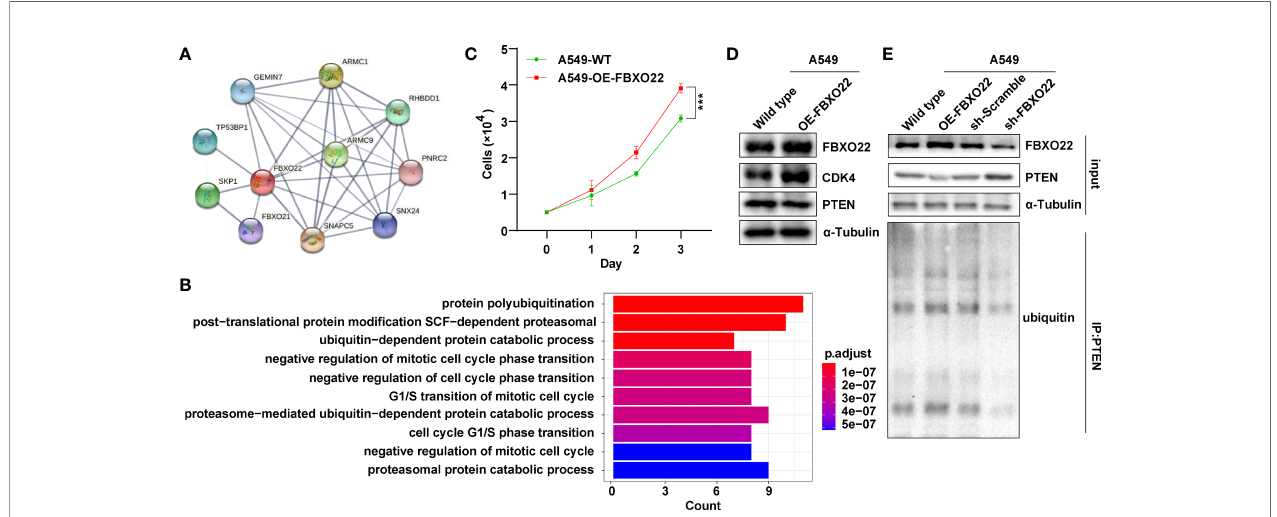
FIGURE 3 | FBXO22 promotes cell cycle progression. (A) Network diagram of FBXO22-binding proteins obtained from the STRING database. (B) Based on the corresponding genes of the FBXO22-binding proteins, their associated biological processes were investigated using Gene Ontology (GO) enrichment analysis. (C) Growth of wild-type and FBXO22 -overexpressing A549 cells. (D) CDK4 expression in wild-type and FBXO22 -overexpressing A549 cells. (E) Western blot analysis of PTEN protein levels and polyubiquitination in A549 cells stably expressing FBXO22 , transfected with SH scramble or sh-FBXO22. *** p < 0.001.